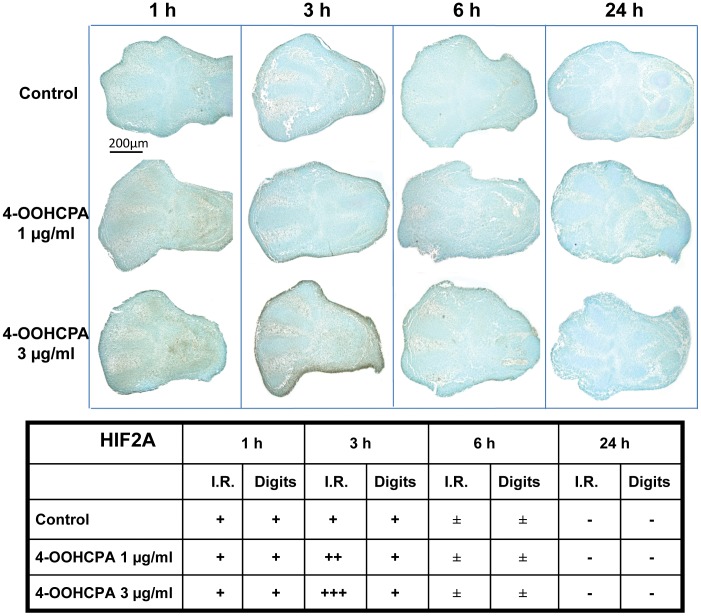
Localization of HIF2A immunoreactivity in limbs.HIF-2A reactivity was detected in control limbs at 1 and 3 h in the apical ectodermal ridge, interdigital area (I.R.) and developing cartilaginous anlagen (Digits). 4-OOHCPA exposure increased HIF2A immunoreactivity in the apical ectodermal ridge and interdigital regions (I.R.) at 3 h. No differences were observed between control and drug-treated limbs after 6 h or 24 h of culture. Four separate replicates were done.